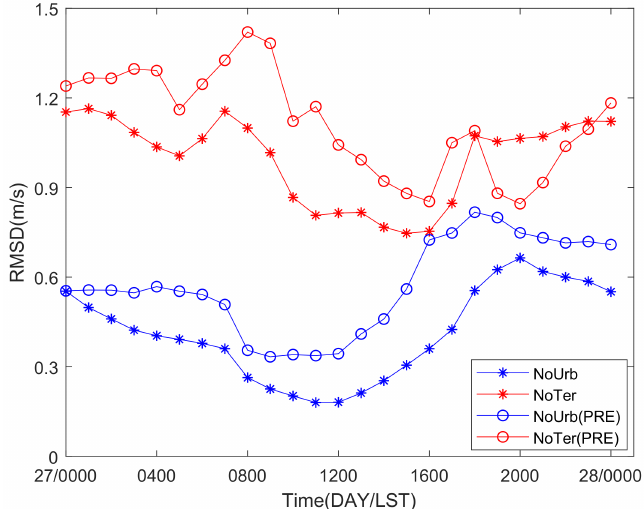
Figure 9. The time evolution of spatial averaged wind speed RMSD of NoTer (red) and NoUrb (blue) versus CTRL for d03 (solid line with an asterisk) and PRE (shown in the white dotted box in Figure 8a, a solid line with circle),